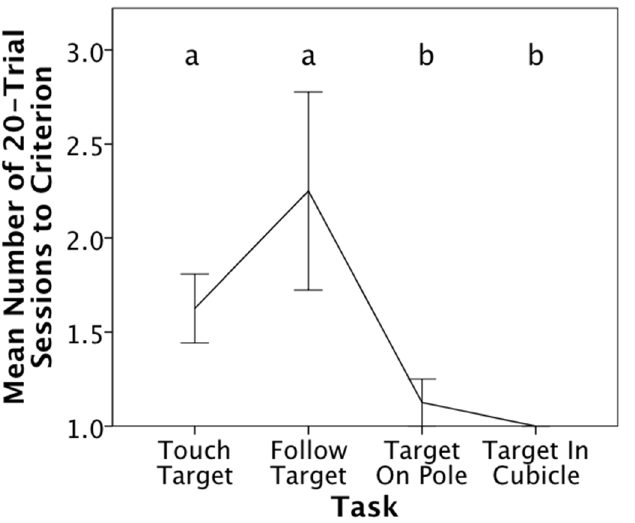
Figure 6. Mean Number of 20-trial sessions taken to reach the criterion of two consecutive errorless 10-trial blocks for each of the four training stages in Phase 1. Errorless responding would result in reaching the criterion in the initial session. Different letters represent significant differences in mean sessions to learn the task; error bars show standard